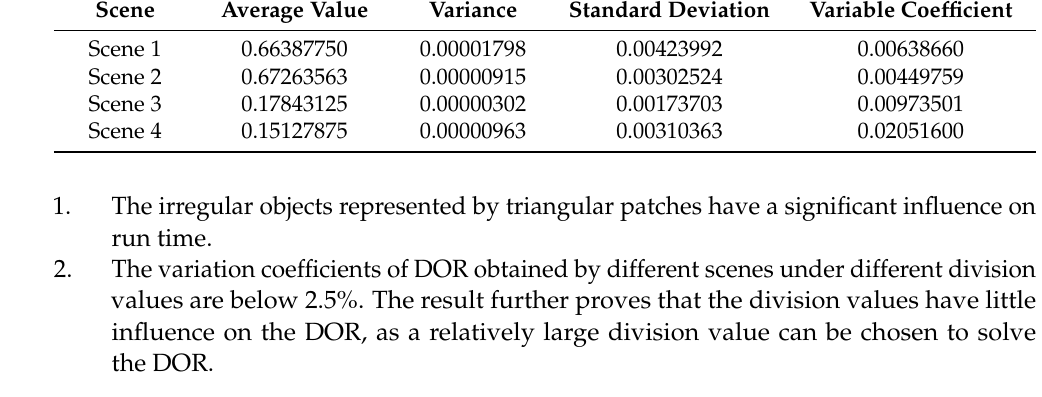
Table 9. Statistical Parameters of the DOR of Each Scene Obtained under Different Division Values.